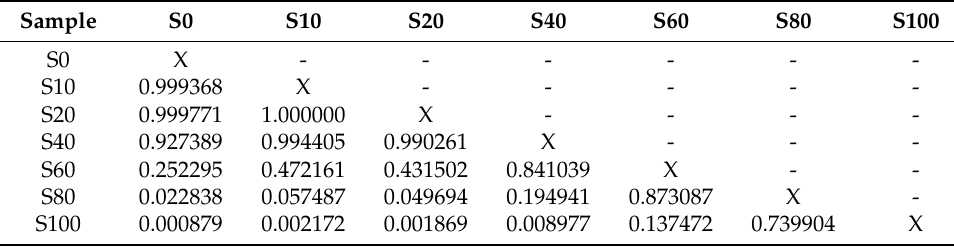
Table A3. Post-hoc analysis by Tukey’s test of the B